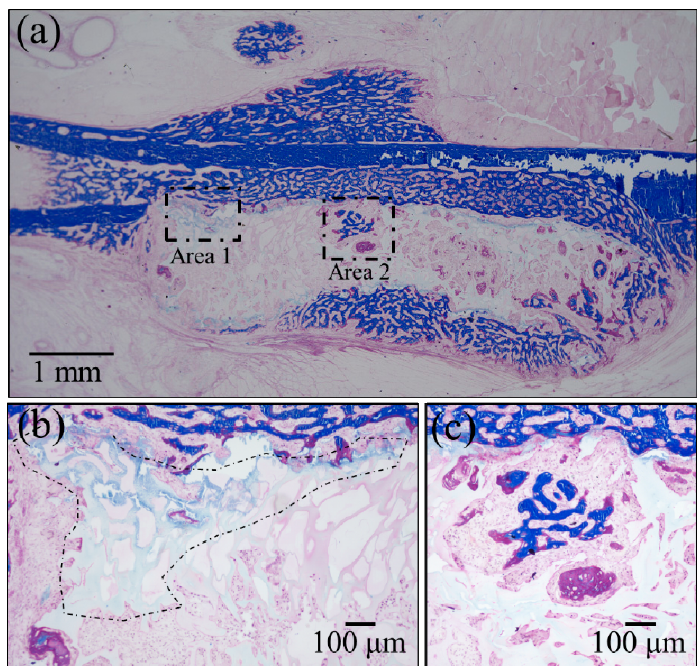
Figure 6. Results of Masson’s trichrome staining: ( a ) low-resolution histological image of the regenerated bone treated with the NanoCliP-FD scaffold; enlargements of the square insets are shown in ( b ) and ( c ) for Area 1 and Area 2, respectively; mature bone in deep blue, collagen in light blue, and immature bone in violet colors.